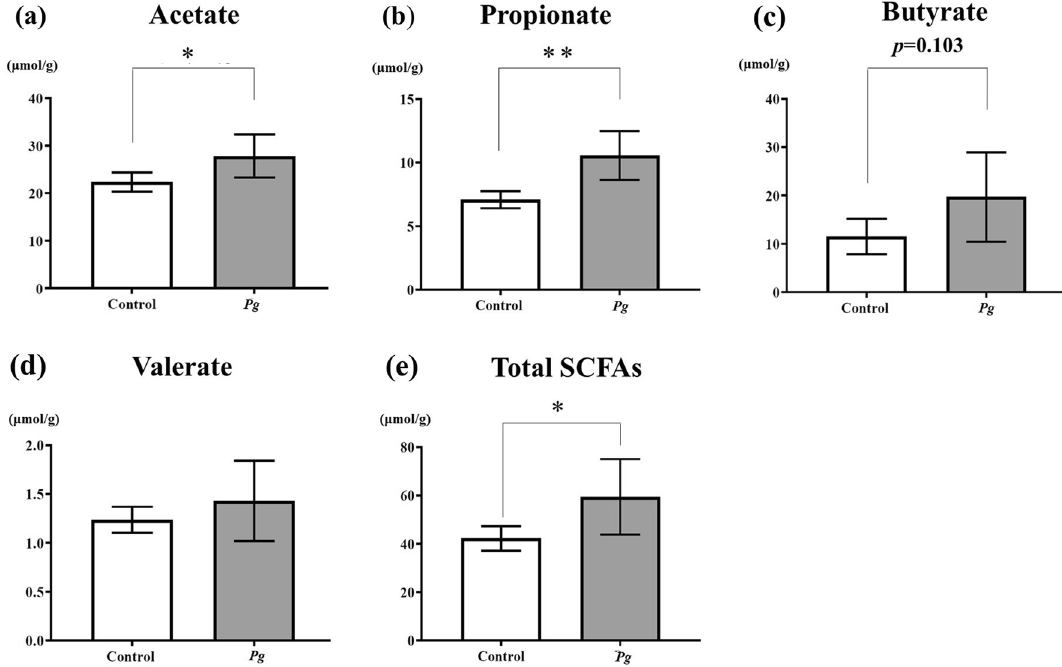
Figure 3. SCFAs in both groups. Short-chain fatty acid (SCFA) levels in the feces of mice from the Pg group and the control group, as determined by gas chromatography (each group: n = 5). ( a ) Acetate, ( b ) propionate, ( c ) butyrate, ( d ) valerate, ( e ) total SCFAs (total concentrations of acetate, propionate, butyrate, valerate, and caproate). * p < 0.05, ** p <